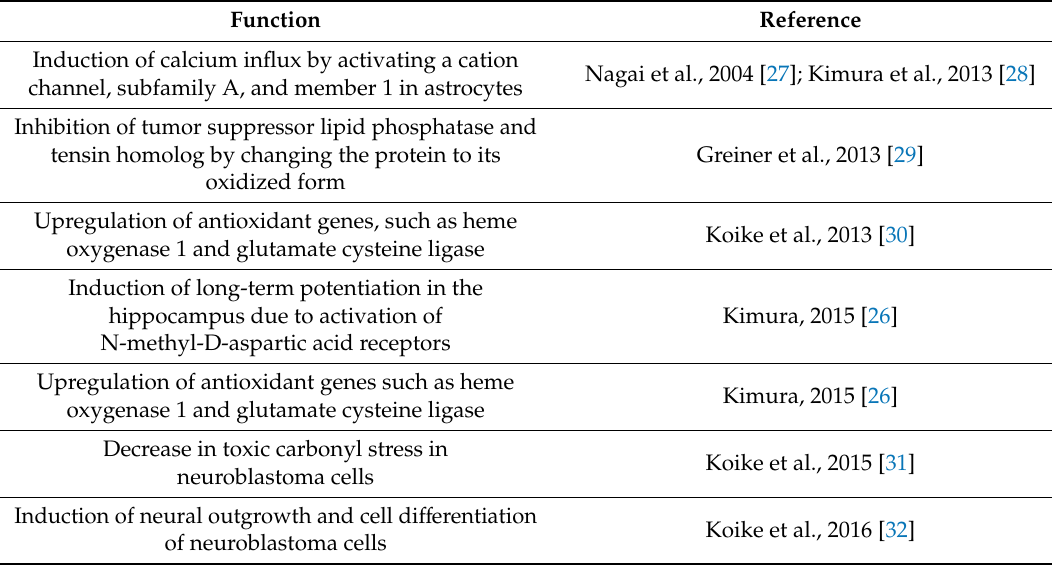
Table 2. Physiological function of